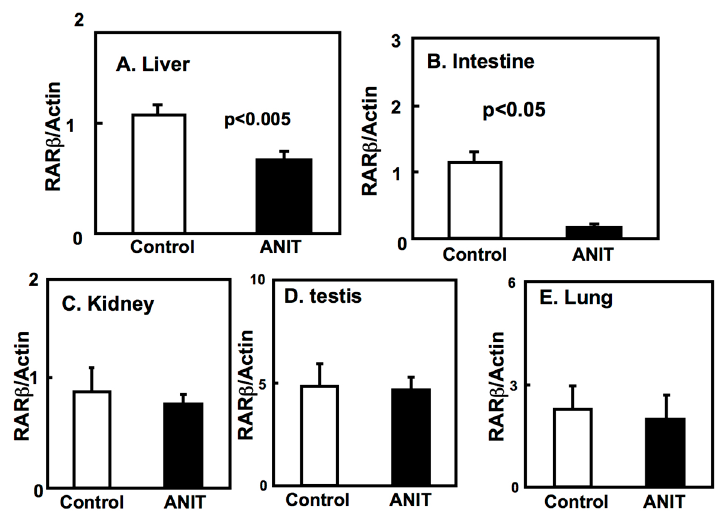
Figure 6. Tissue-specific expression of RAR β in control and ANIT rats. RAR β mRNA levels of peripheral tissues including liver ( A ), intestine ( B ), kidney ( C ), testis ( D ), and lung ( E ) were examined by quantitative real-time PCR in treated and control groups ( n = 5 for each group). Each bar represents the mean value ± SD and significant differences are indicated in the graph.